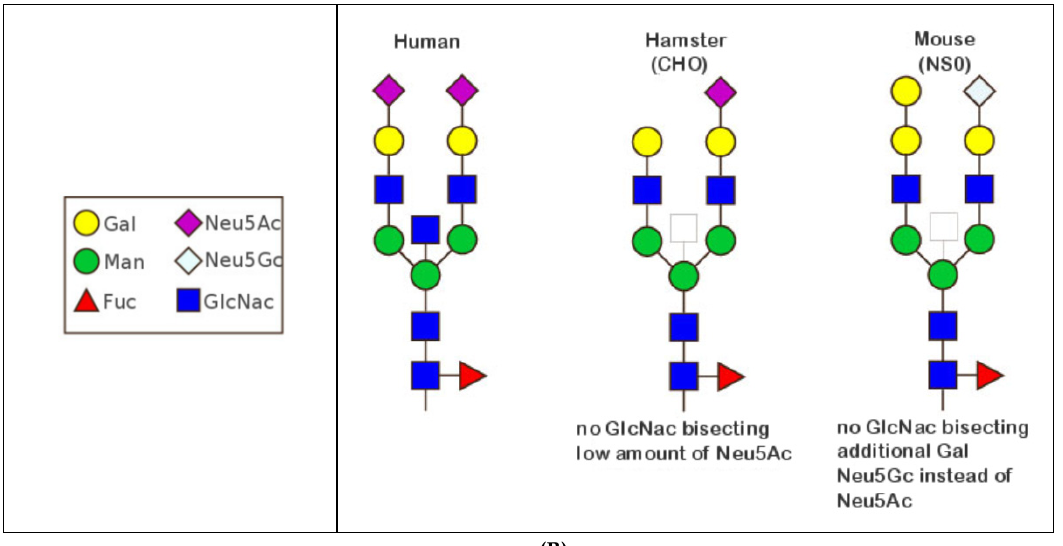
Figure 36. ( A ). Largest N-linked oligosaccharide structure found in human IgG (left panel) and most abundant glycans found in mAb biopharmaceuticals (right panel). ( B ). Glycosylation patterns of recombinant antibodies produced in human, CHO and NS0 cells. Symbol Nomenclature for Glycans